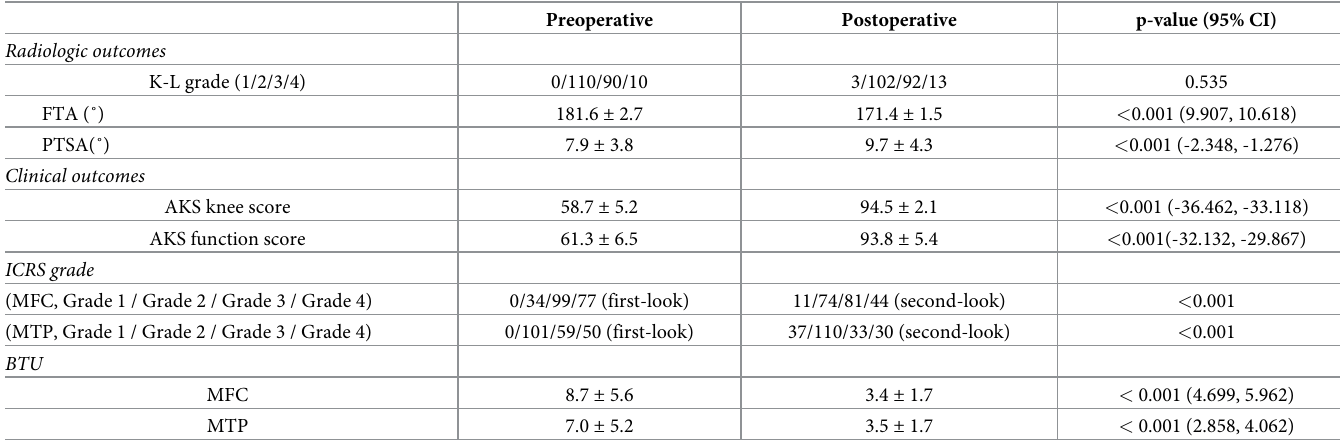
Table 2. Comparison of radiologic, clinical outcomes, arthroscopic findings and BTU in bone scintigraphy preoperatively and postoperatively. Preoperative Postoperative p-value (95%